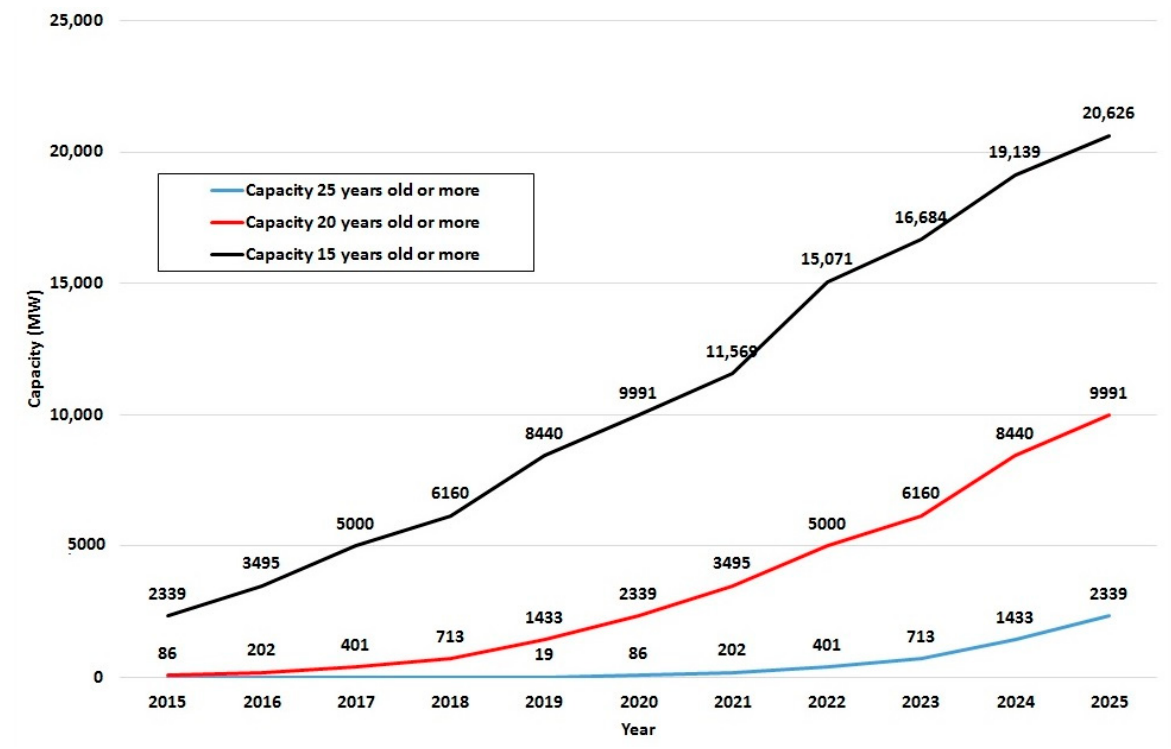
Figure 3. Trend in the age of Spanish wind farms with installed capacity. Source: drawn up by authors with data from AEE [6].